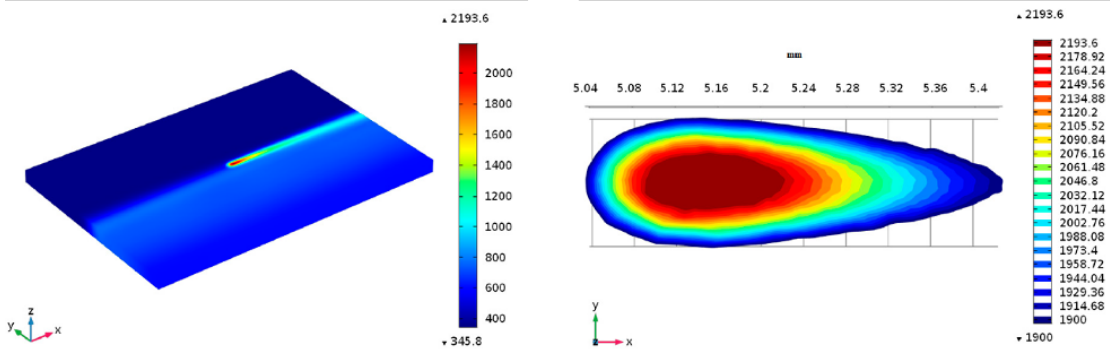
Figure 2. Temperature contours during selective laser melting (SLM) process on Ti6Al4V powder bed